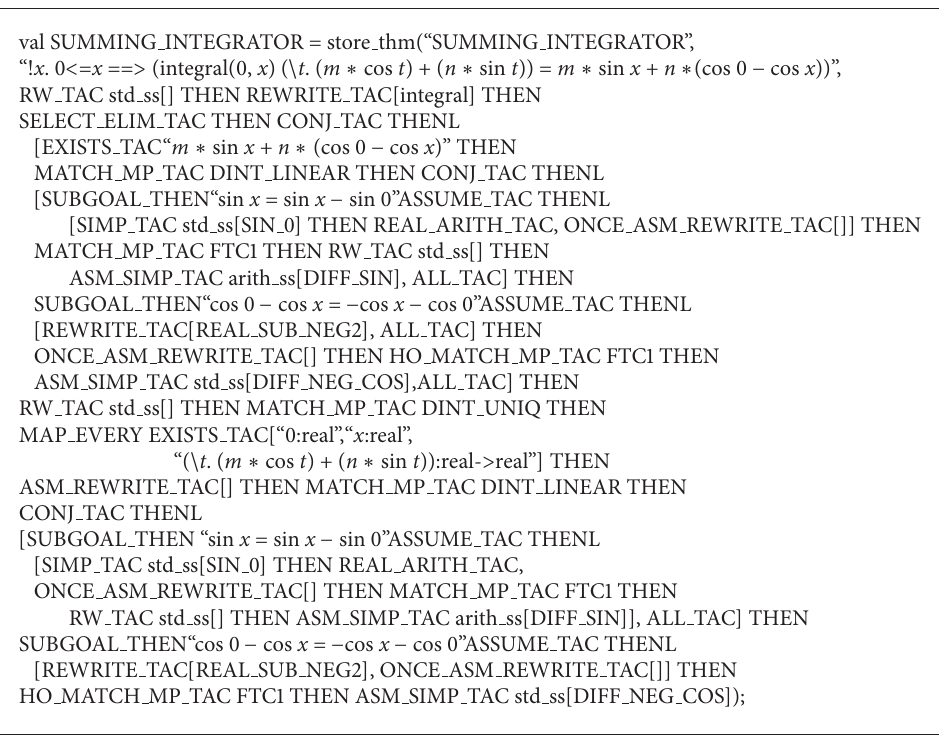
Algorithm 1: The formalization and proof of SUMMING INTEGRATOR.